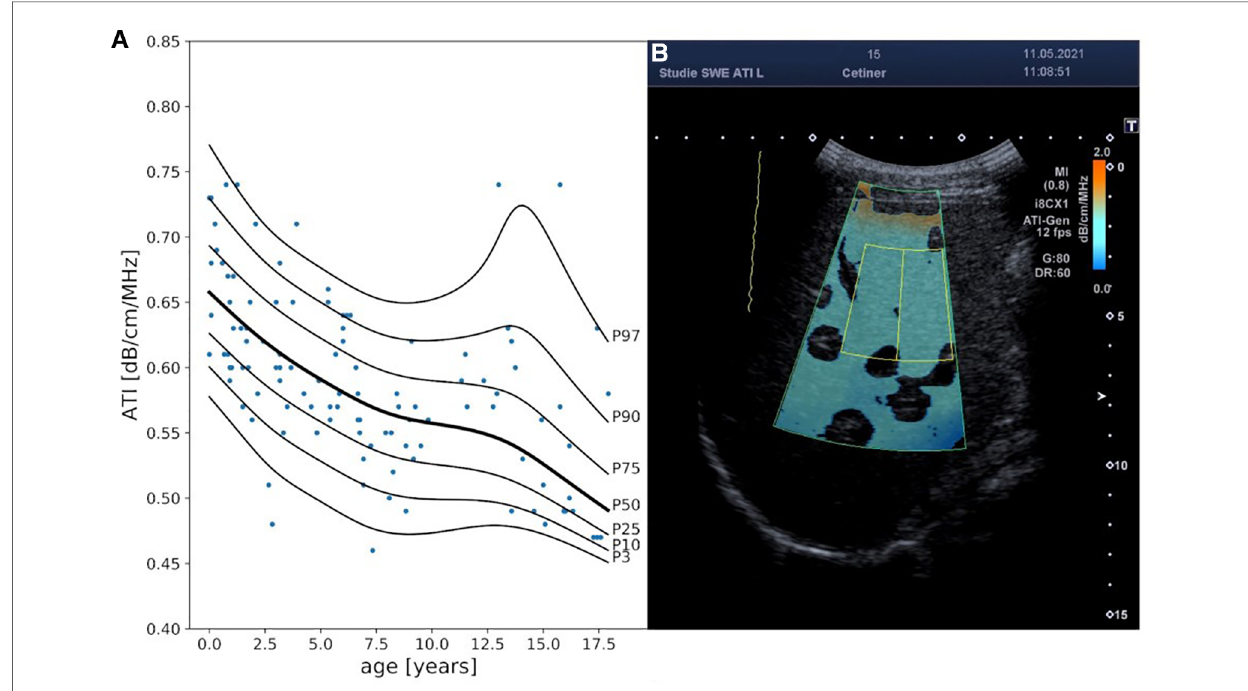
FIGURE 4 Attenuation index (ATI) reference curves and exemplary 2D ultrasound ATI image. Panel A displays ATI percentile curves values in [db/cm/MHz] in relationship to age (years). Panel B exemplary represents an ATI measurement in a 15-year-old boy. MI, mechanical index; i8CX1, canon aplio i8CX1 transducer; fps, frames per second; G, gain; DR, dynamic